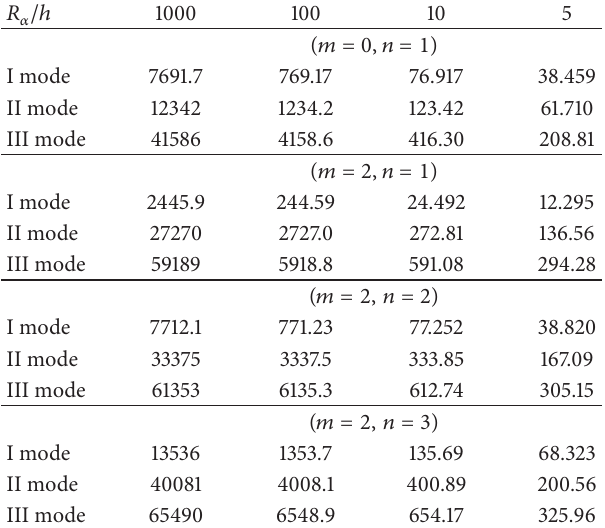
Table 11: Benchmark 7. Simply supported isotropic cylinder. First three vibration modes in term of no-dimensional circular frequency 𝜔 = 𝜔(𝑎 2 /ℎ)√𝜌/𝐸 for several combinations of half-wave numbers 𝑚 and 𝑛 . 𝑀 = 100 fictitious layers and 𝑁 = 3 order of expansion for the exponential